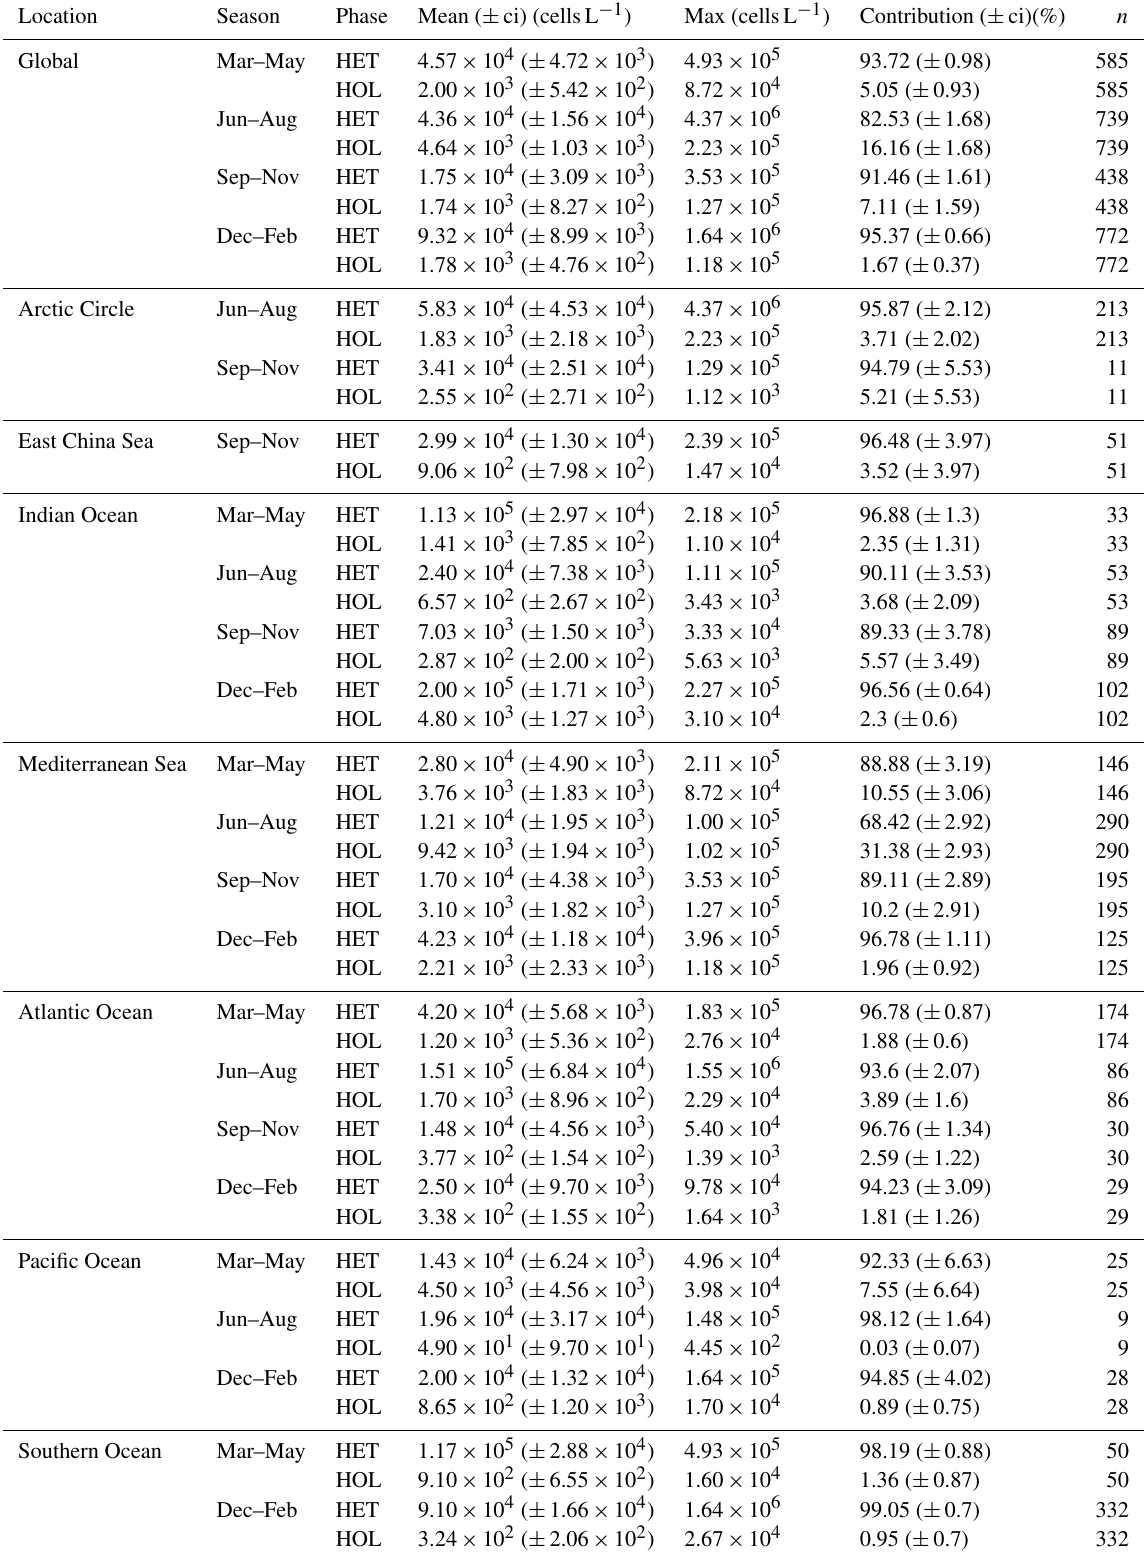
Table 3. Global heterococcolithophore and holococcolithophore abundance. Location